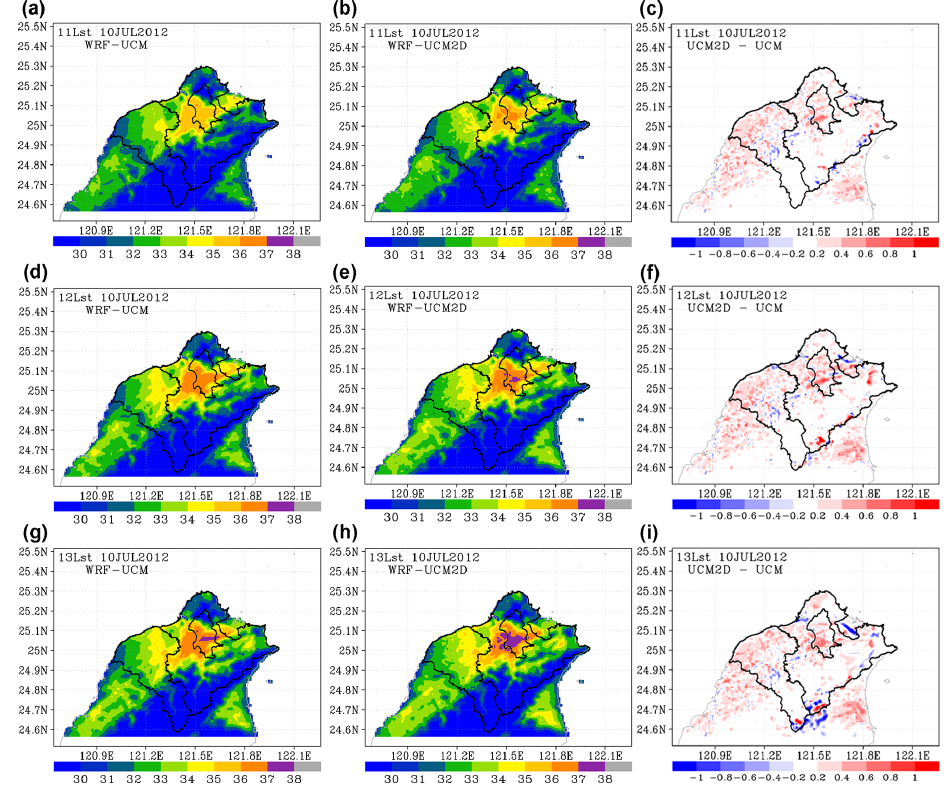
Figure 4. Spatial distribution of air temperature on 10 July 2012 simulated by WRF–UCM and WRF–UCM2D and the difference between WRF–UCM2D and WRF–UCMat for (a, b, c) 11:00LST, (d, e, f) 12:00LST, and (g, h, i) 13:00LST. Unit is degrees Celsius. Table 1. Bias, RMSE, and R 2 calculated using simulated temperatures at 19 urban stations for 8–11 July 2012, for daytime, and for nighttime obtained by WRF–UCM and